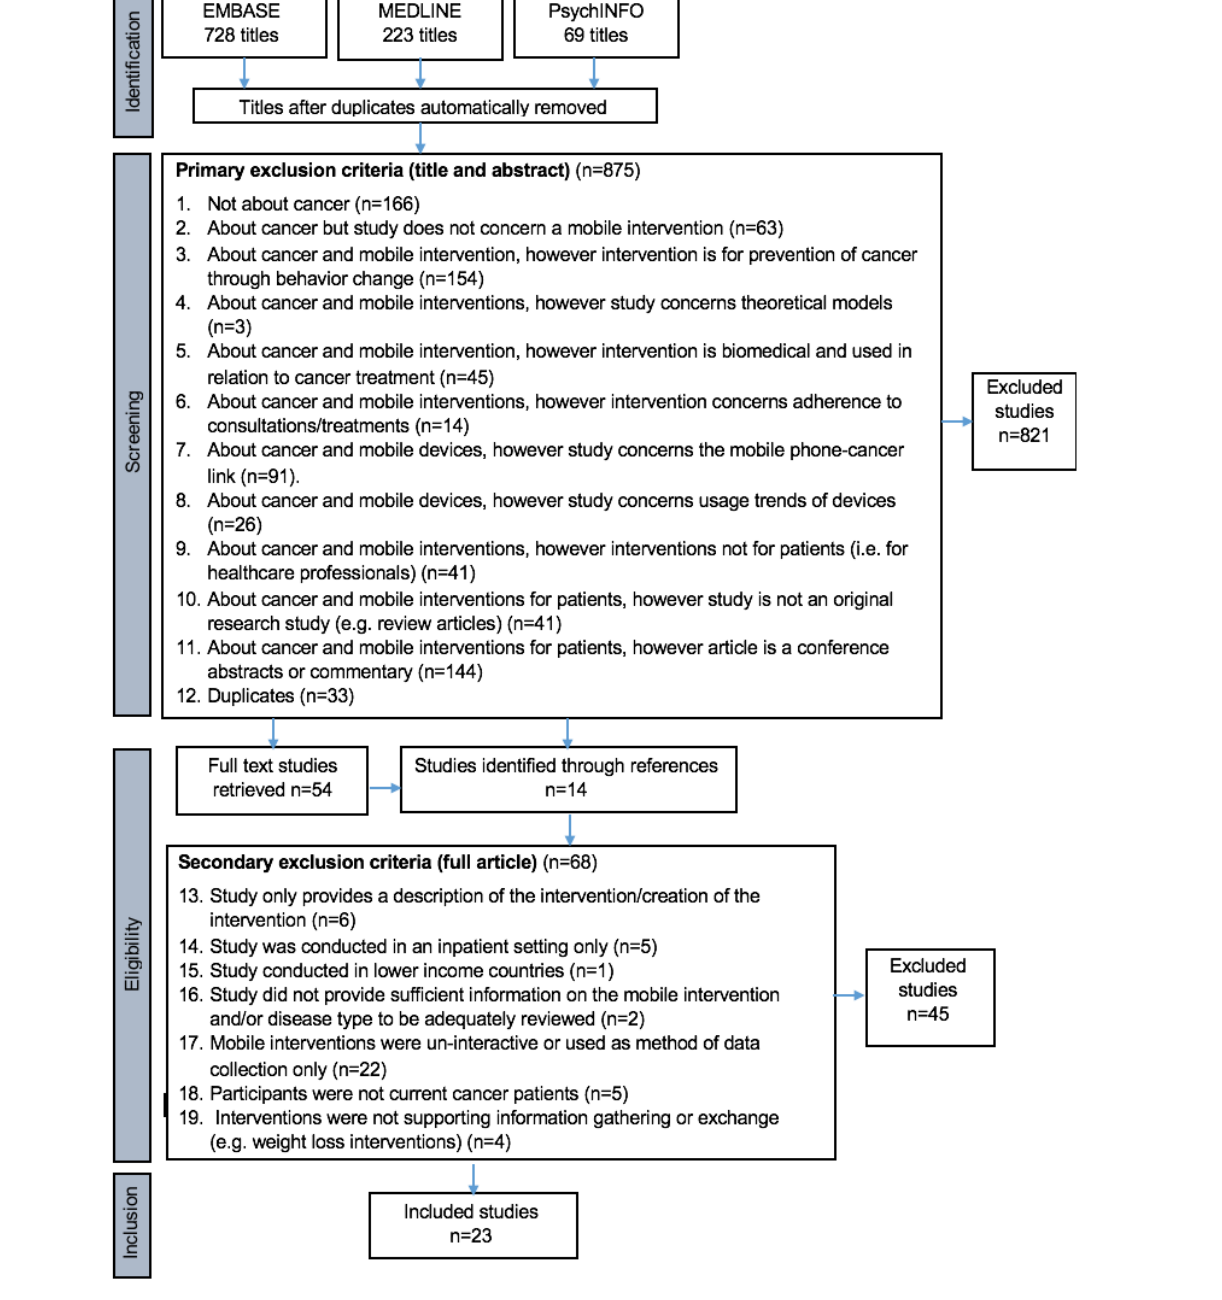
Figure 1. PRIMSA